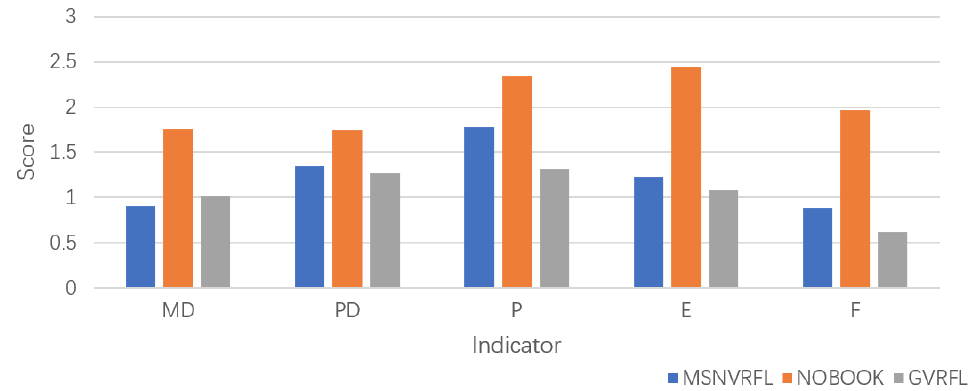
Figure 23. NASA user evaluation.